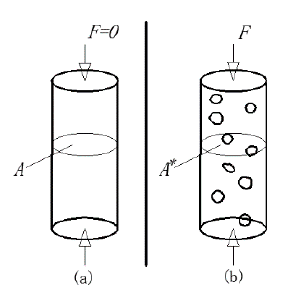
Figure 1. Di ff erent straight rod states under pressure. ( a ): an initial straight rod without damage. ( b ): a straight rod after compression